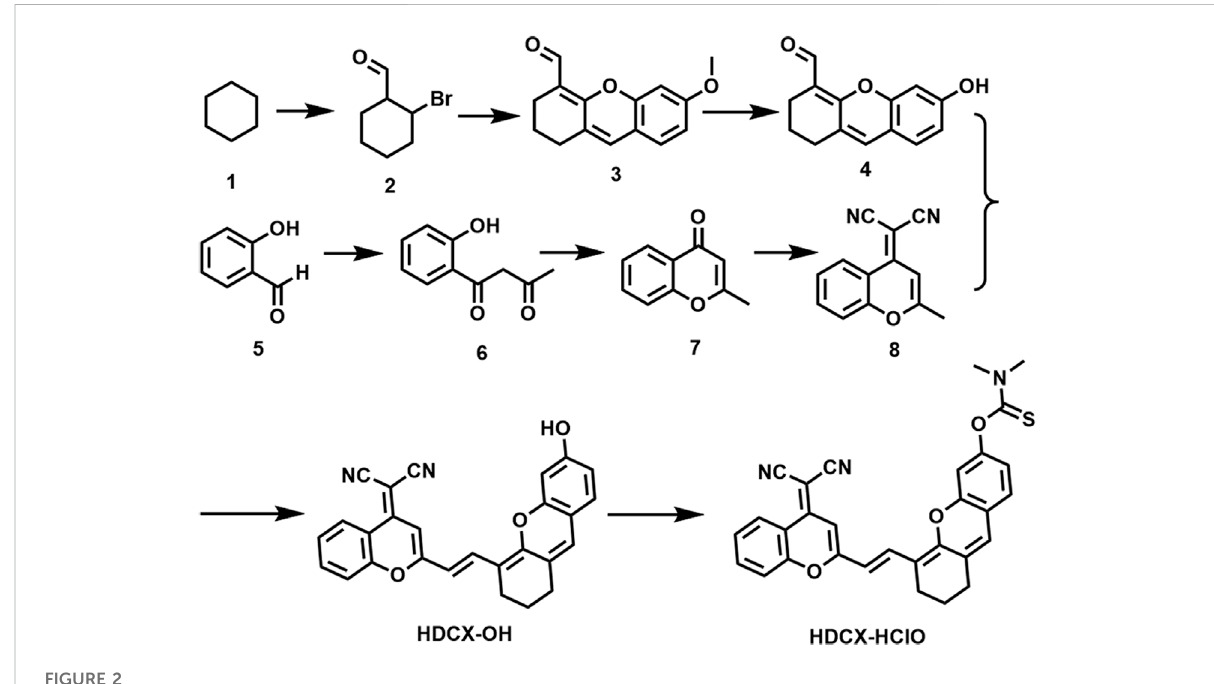
FIGURE 2 Synthesis route of compound HDCX-HClO.